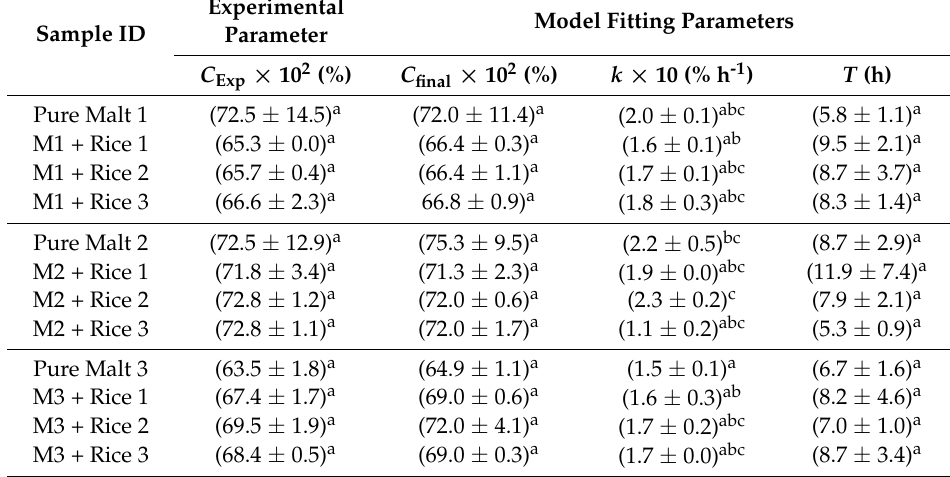
Table 4. Final ethanol concentration after fermentation and the model fitting parameters of ethanol production during fermentation 1